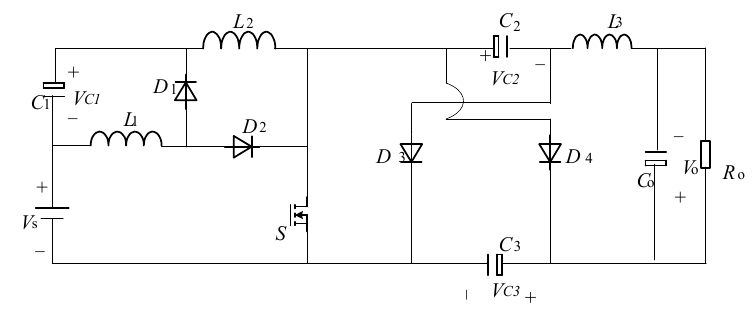
Figure 3. Diagram of the proposed converter.